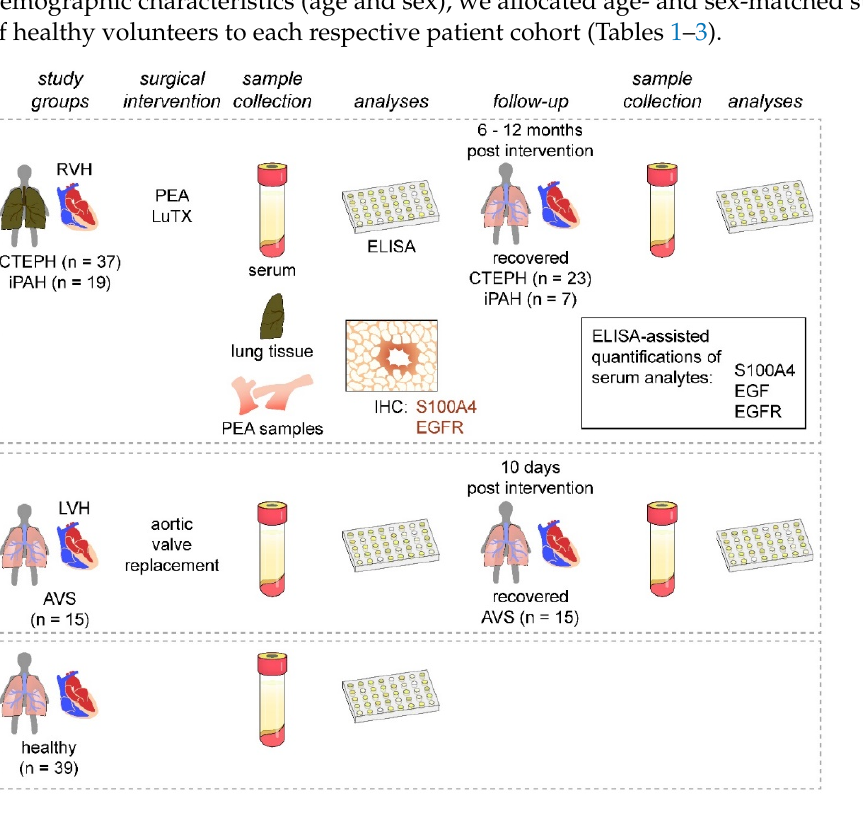
Figure 1. Study design. Patients presenting with PH (CTEPH and iPAH) and RVH were enrolled and compared to patients with AVS and LVH. Healthy volunteers served as controls. Serum samples were obtained from all study groups and during patient follow-up visits after surgical interventions. Serum samples were analyzed for S100A4, EGF, and EGFR. Endarterectomized specimens and iPAH lung tissues were used for immunohistochemical assessment of S100A4 and EGFR expressions.